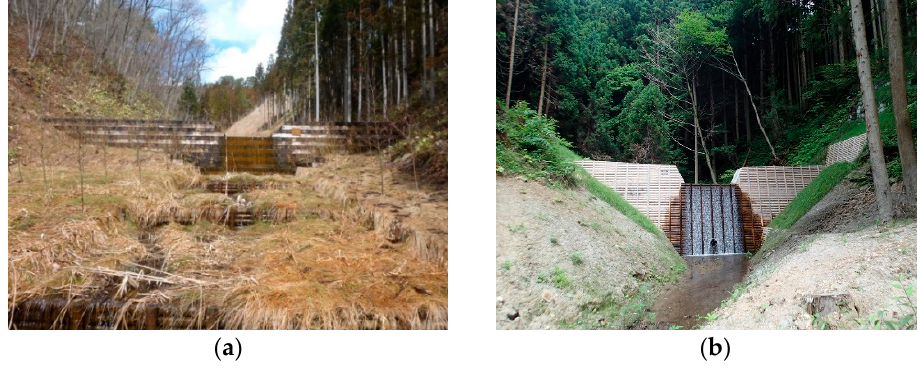
Figure 1. ( a ) A timber dam; ( b ) a concrete dam [19].